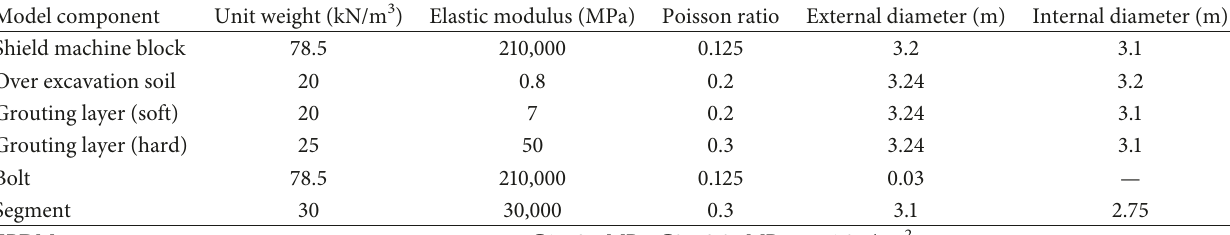
Figure 5: Multiscale hybrid model. (a) Critical section of the tunnel under water inrush. (b) Hybrid model of critical Section D. Table 2: Material